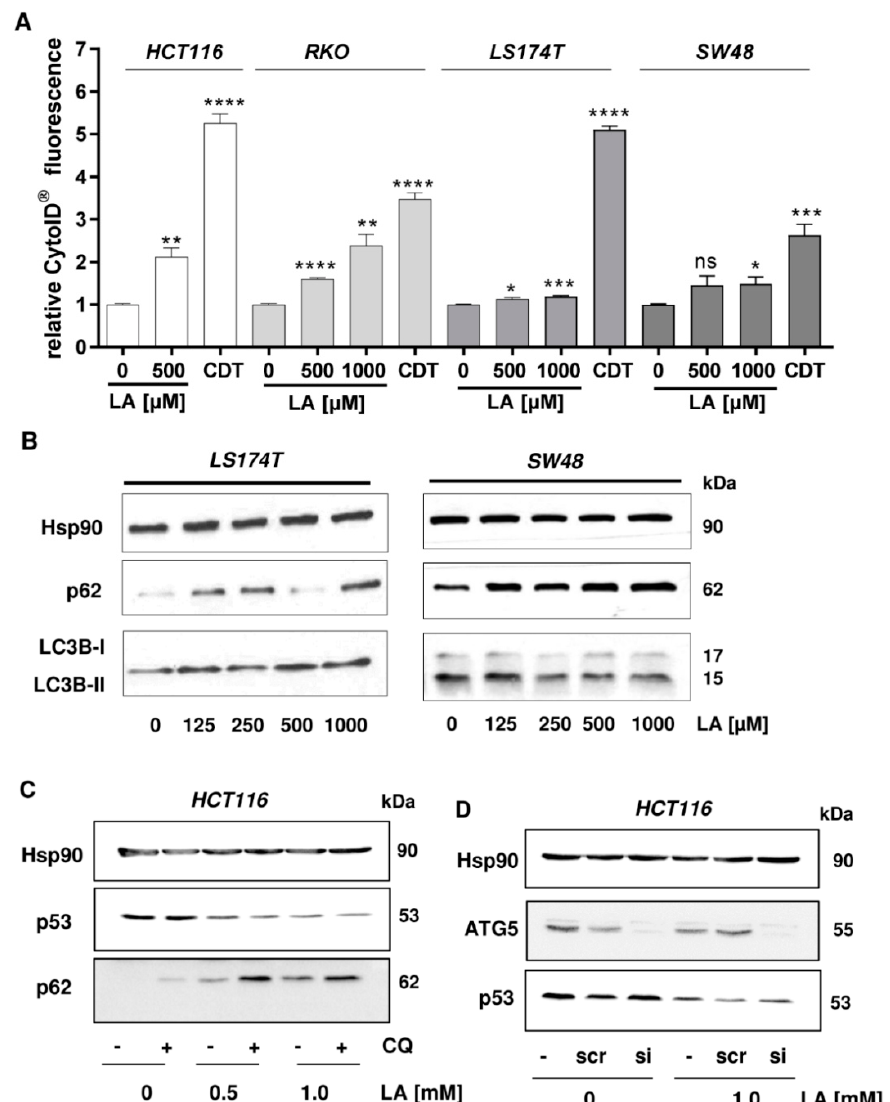
Figure 4. Autophagosome formation and p62 accumulation by LA in CRC cells and contribution of autophagy to p53 depletion. ( A ) Relative autophagosome levels in HCT116, RKO, LS174T, and SW48 cells after 48 h of LA treatment determined by the CytoID ® Autophagy Detection Kit and flow cytometry. EtOH was used as solvent control (0 µ M LA). Cytolethal distending toxin (CDT) served as positive control. Data are shown as mean + SEM ( n = 4). ns p > 0.05; * p < 0.05; ** p < 0.01; *** p < 0.001; **** p < 0.0001. ( B ) The autophagy marker LC3B and accumulation of the autophagy receptor p62 were visualized by western blot analysis of LS174T and SW48 cells treated with increasing doses of LA for 48 h. Hsp90 served as loading control. ( C ) Pharmacological inhibition of autophagy and impact of LA on p53 status. HCT116 cells were incubated with LA for 48 h as indicated. CQ was added 16 h prior to harvesting of the cells. Whole-cell extracts were separated by SDS-PAGE followed by western blot analysis of p53 and p62. Hsp90 served as loading control. ( D ) Genetic abrogation of autophagy and p53 depletion by LA. HCT116 cells were transiently transfected with ATG5 siRNA or scrambled (scr) siRNA. Cells were then incubated with 1 mM LA or the solvent control EtOH (0 mM LA). Samples were subjected to SDS-PAGE and western blot analysis of p53. Successful knockdown was confirmed by immunoblot detection of ATG5, while Hsp90 was used as loading